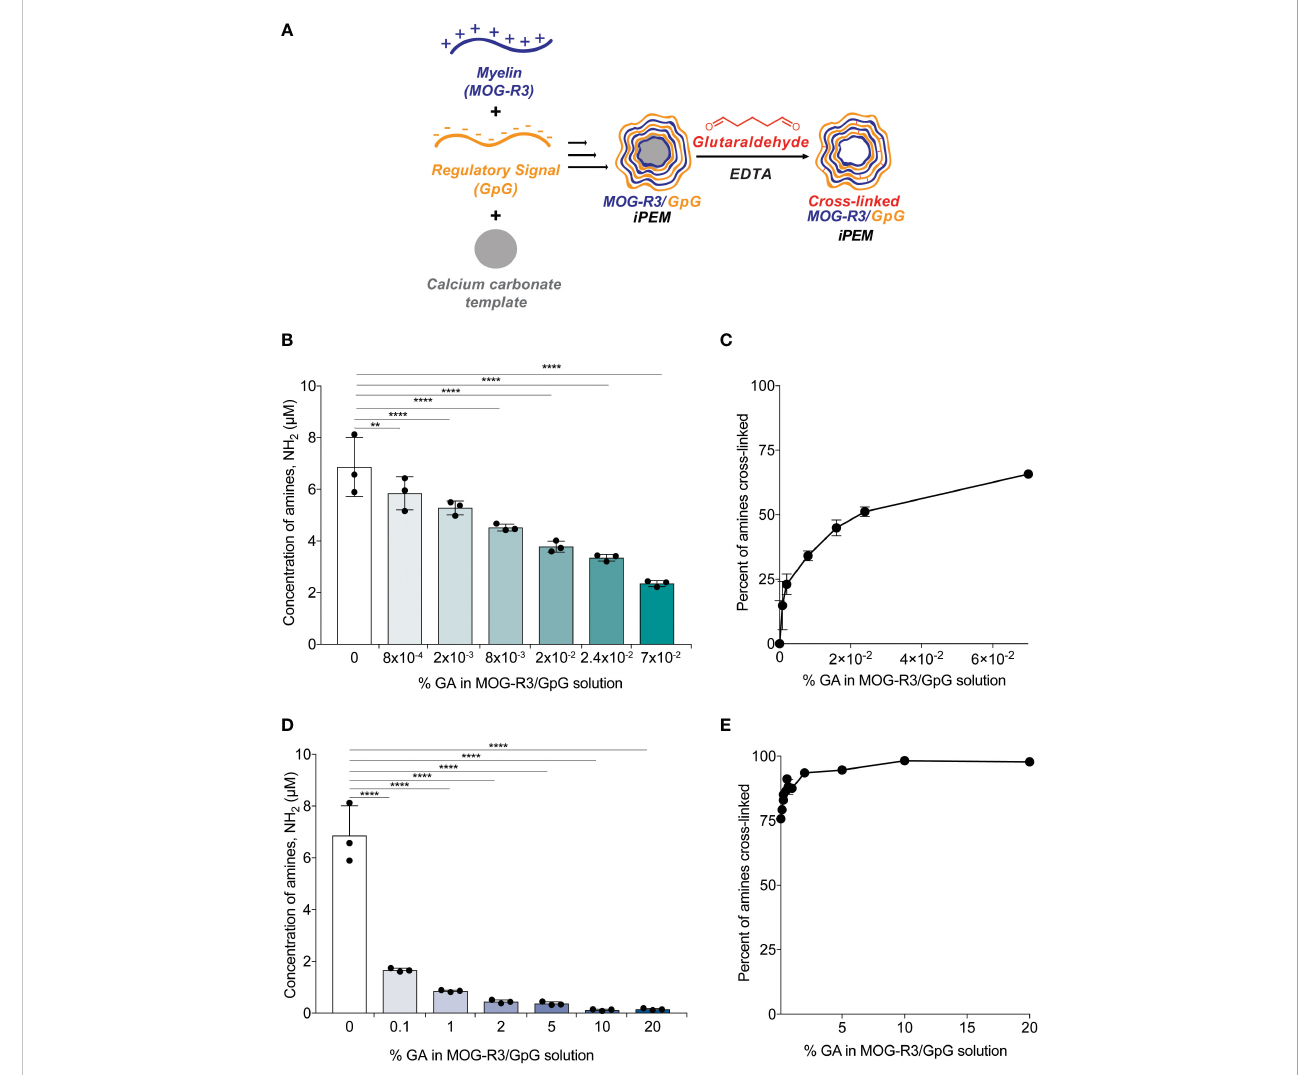
FIGURE 2 Cross-linking density can be modulated by changing the percent of glutaraldehyde in solution. (A) Schematic view of layer-by-layer electrostatic assembly of myelin self-antigen (MOG-R3) and TLR9 antagonist (GpG) on sacri fi cial template, followed by glutaraldehyde mediated crosslinking. (B – E) Fluoraldehyde assay showing degree of crosslinking after 5 minutes of GA incubation. Data represents mean ± standard deviation. **p < 0.01, ****p < 0.001 versus 0% GA iPEMs using one-way ANOVA and Dunnett ’ s multiple comparisons